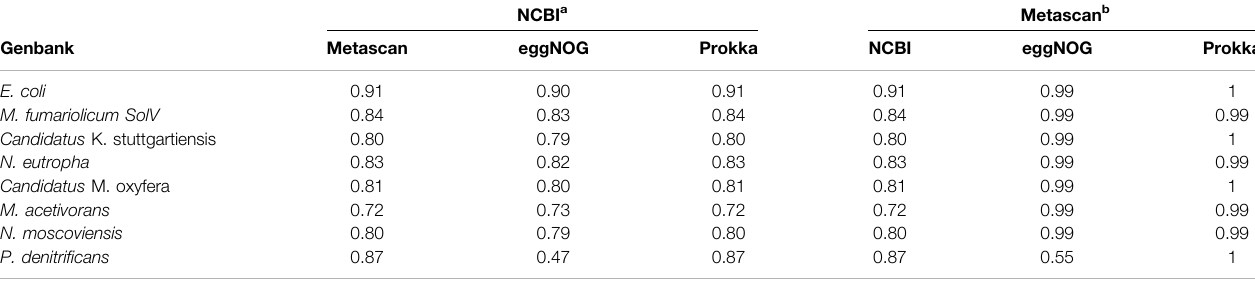
TABLE 5 | BEACON (F1) scores comparisons of the GenBank fi les created by Prokka, Metascan, eggNOG, and NCBI for all eight genomes. NCBI a